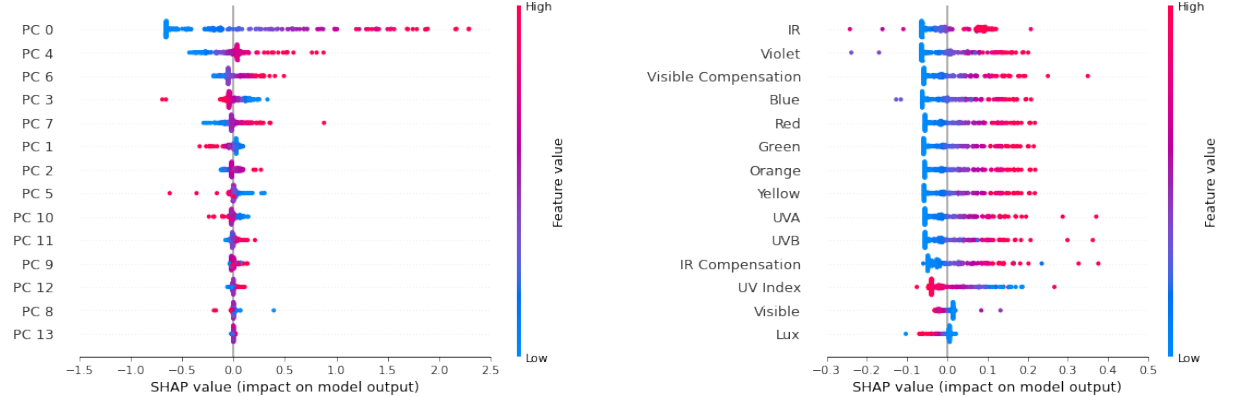
Figure 8. SHAP value of our MLP model, which calibrates the whole spectrum, shows how the PCA features impact the models’ output. The red (blue) color denotes the high(low) value of each feature and the position of point on the x direction shows the impact on the target. The left panel shows the principle components’ SHAP values, and the right panel shows the original features’ SHAP values from the 0th principle component by using linear